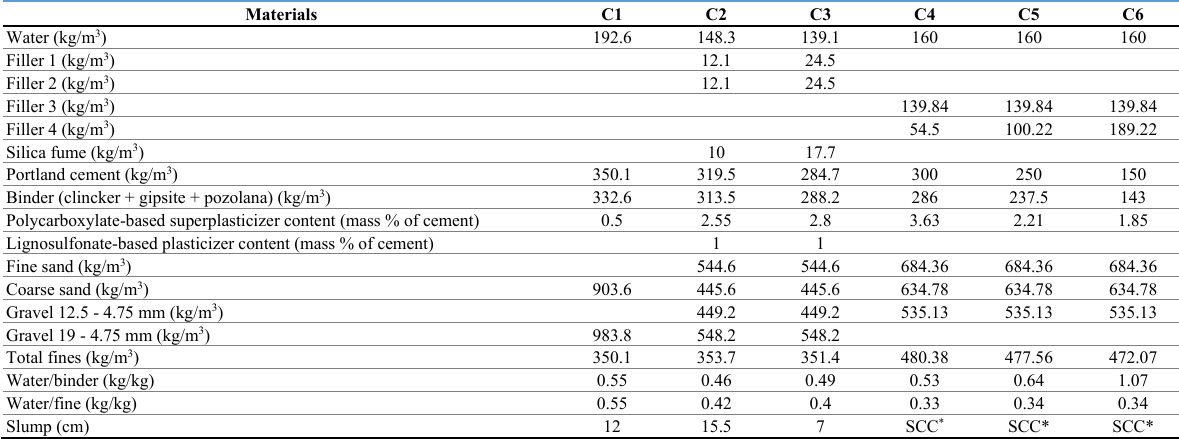
Table 3. Mix design of the cement reduced concretes.